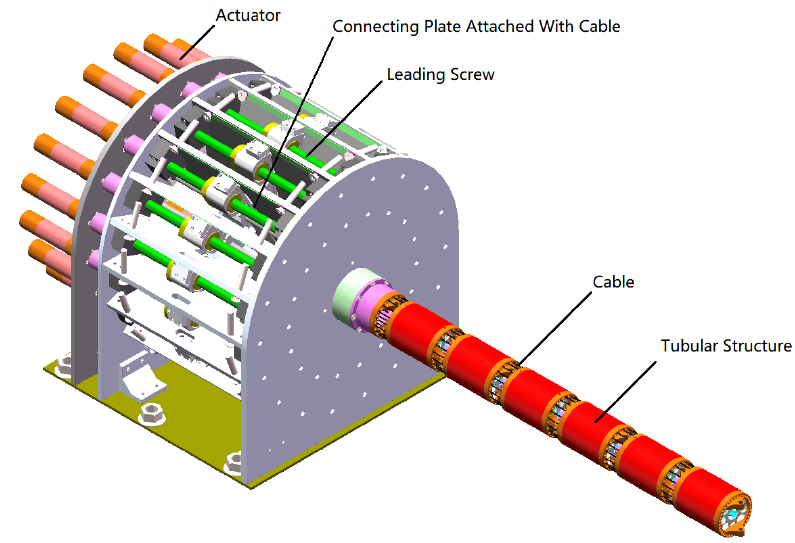
Figure 3. Overall structure design of cable-driven hyper-redundant snake-like manipulator (CHSM).